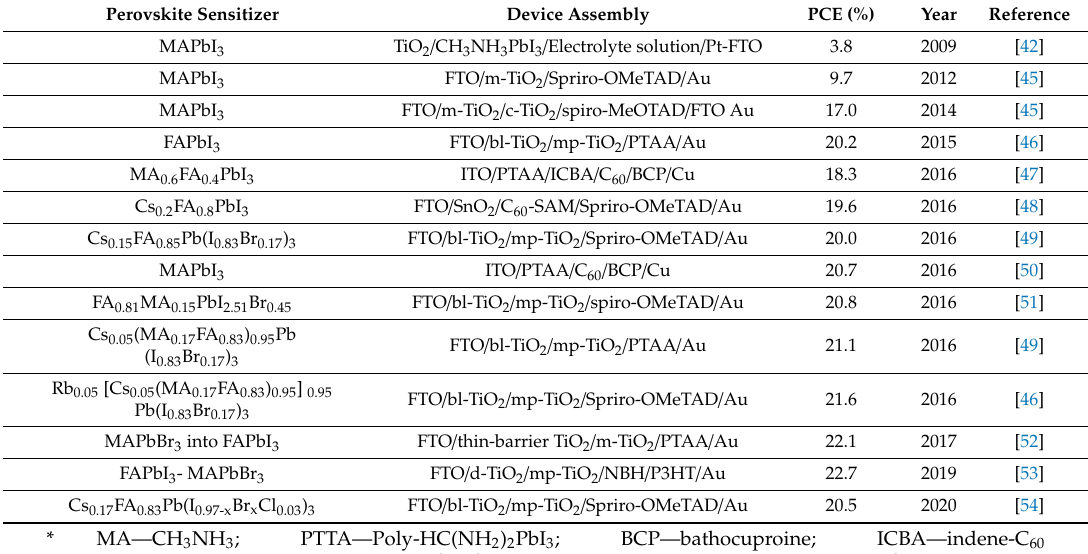
Table 2. Significant performance achievement of experimental planner structure-based perovskite solar cells (PSCs) in consecutive years